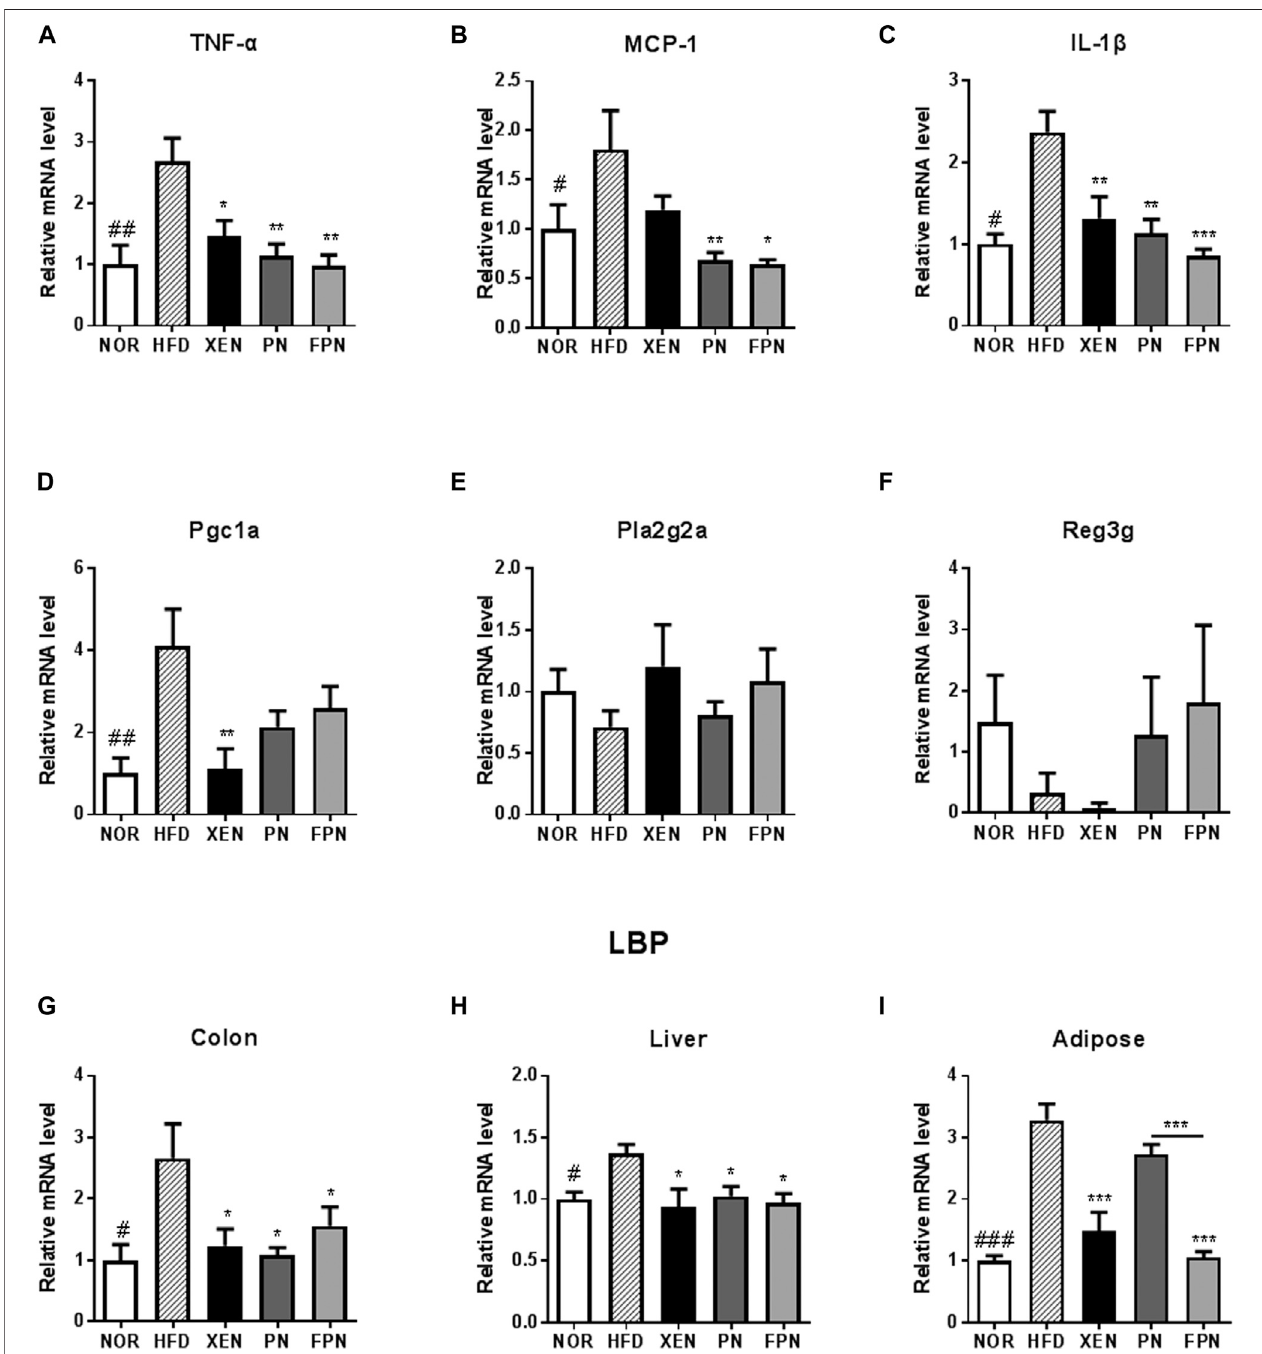
FIGURE6| Effect ofPNandFPNonthegeneexpression ofin fl ammatory mediatorsand antimicrobialpeptidesinaHFD-inducedmousemodel aftertreatmentfor 9 weeks.Expressionsofthegenesofinterestintheintestine,liver,andadiposeweredeterminedbyRT-PCR.Therelativegeneexpressionofthein fl ammatorymediators (A) TNF- α , (B) MCP-1, and (C) IL-1 β as well as relative gene expressions of anti-microbial peptides (D) Pgc1 α , (E) Pla2g2 α , and (F) Reg3 γ were measured in the colon tissue. The relative gene expressions of LPS binding protein (LBP) was measured in (G) colon, (H) liver, and (I) adipose tissue. The data are expressed as the mean ± SEM( n (cid:2) 7 – 8);# p < 0.05;## p < 0.005;### p < 0.001;NOR vs. HFDgroup.* p < 0.05;** p < 0.01;*** p < 0.001;HFDgroup vs.